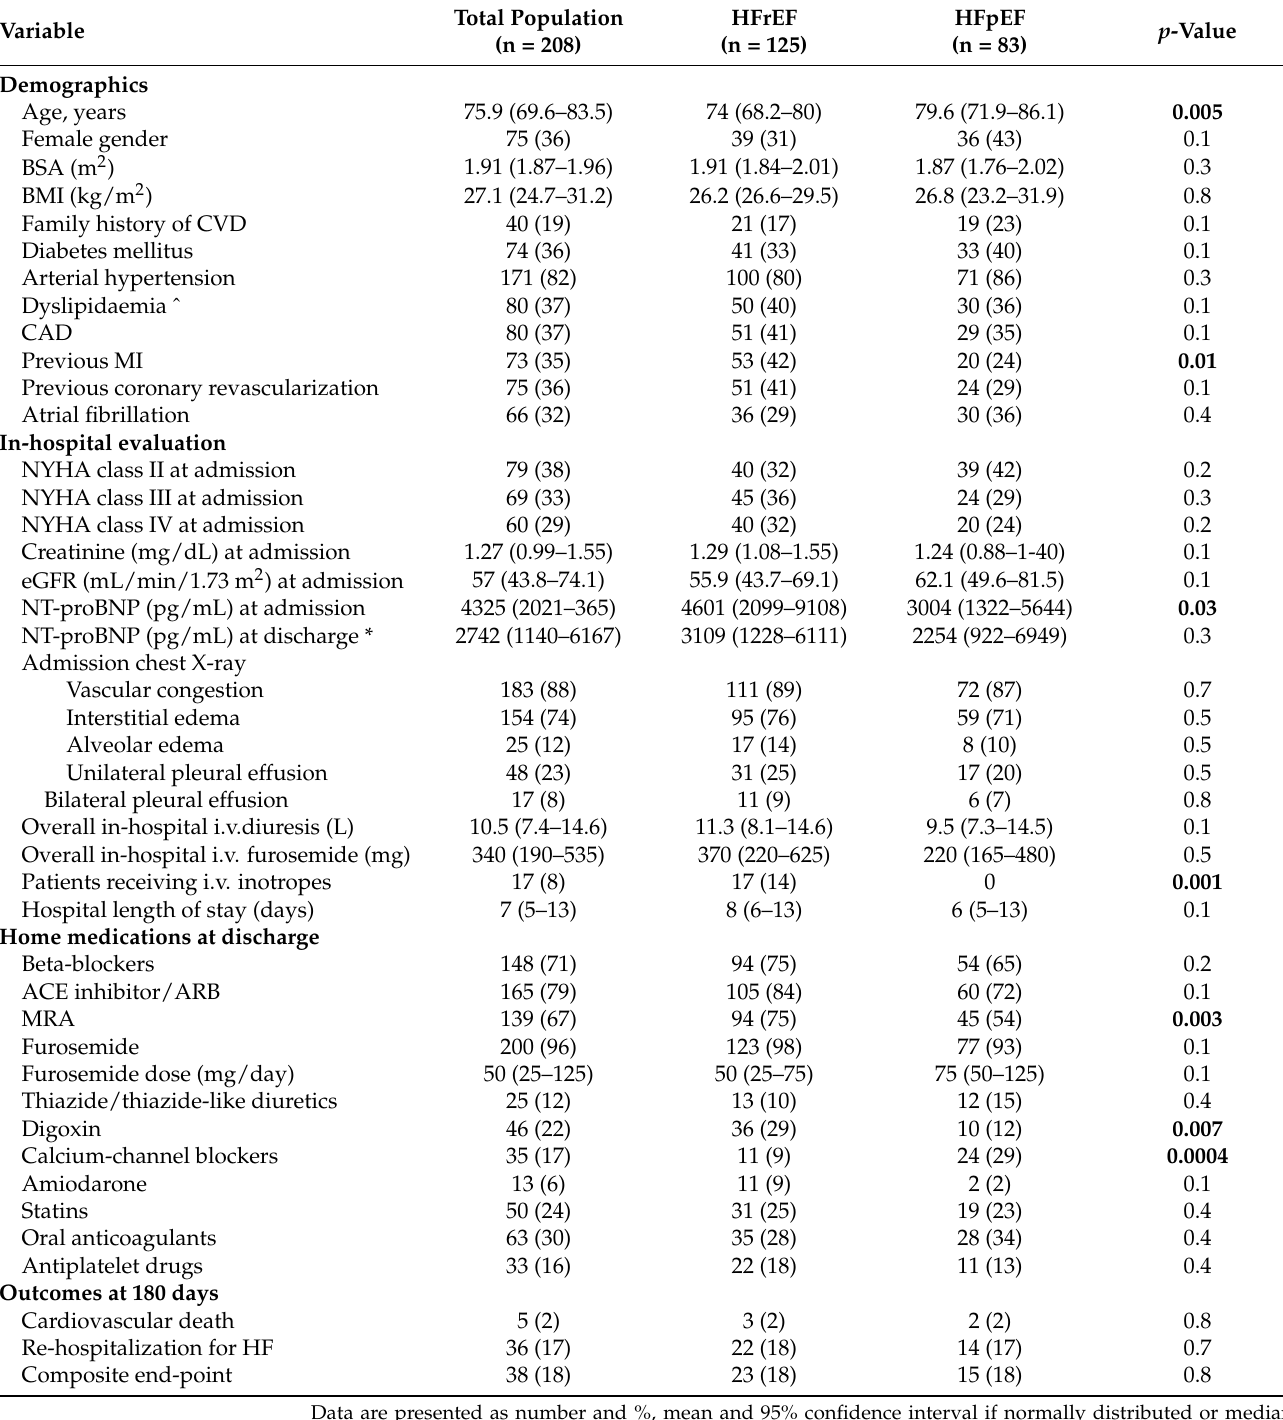
Table 1. Patient clinical characteristics in the overall population and by left ventricle ejection